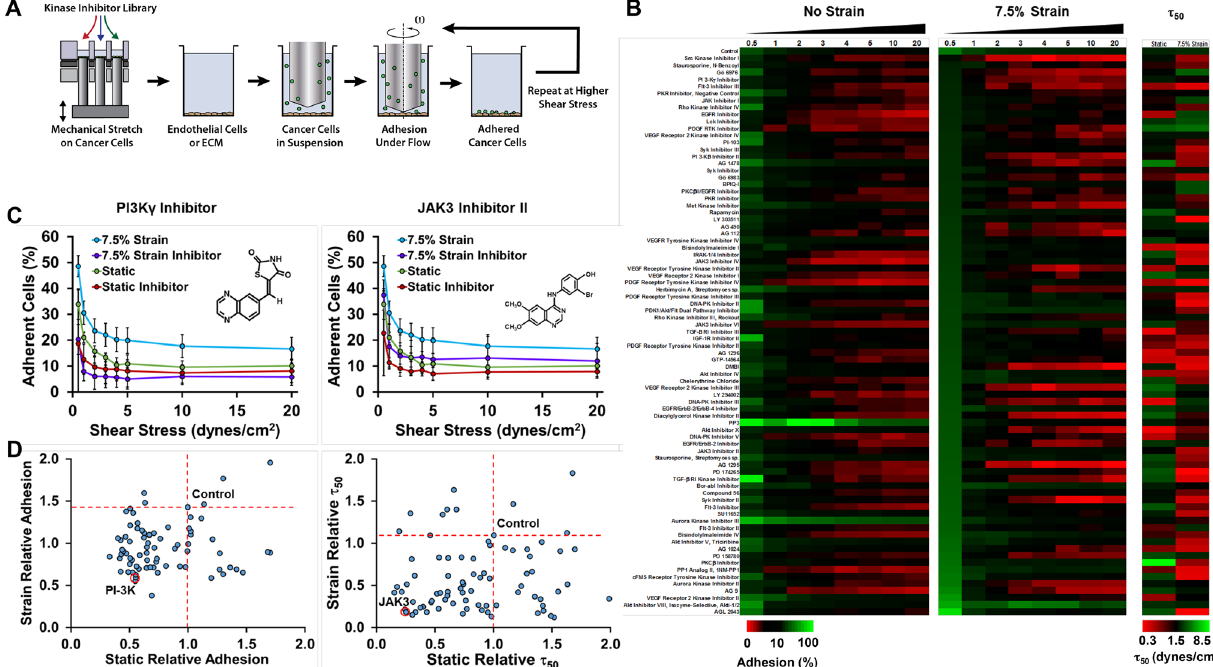
Figure 4. High throughput mechanobiological screens for blocking load-induced enhancement of cancer cells to endothelial cells under shear stress. ( A ) Diagram of experimental protocol. The cells are loaded in the presence of compounds from a kinase inhibitor library and then the adhesion to inflamed endothelial cells under flow is measured. ( B ) Heat map of the adhesion and detachment of cancer cells with treatment with kinase inhibitors. ( C ) Example graphs from the kinase screen for a PI3K inhibitor and Jak3 inhibitor. ( D ) Results of the kinase inhibitor screen. Compounds in the lower left portion of the graph have reduced initial adhesion or τ 50 to endothelial cells. The τ 50 is an index of the strength of adhesion. It is the shear stress needed to cause detachment of 50% of the cells calculated from a curve fit to the detachment of the cells under increases shear